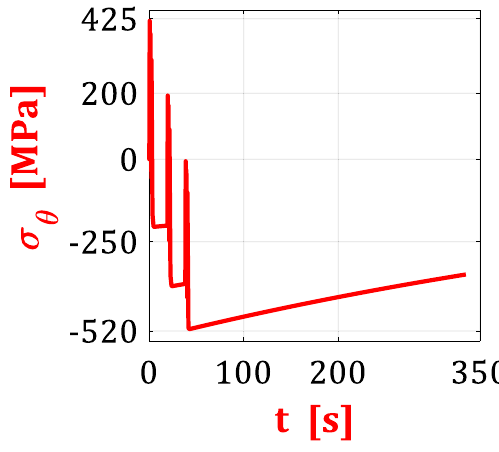
Fig. 22 Hoop stress-time history at the mid- radial section of the thick-walled cylinder due to 85 pulses under the hypothesis of